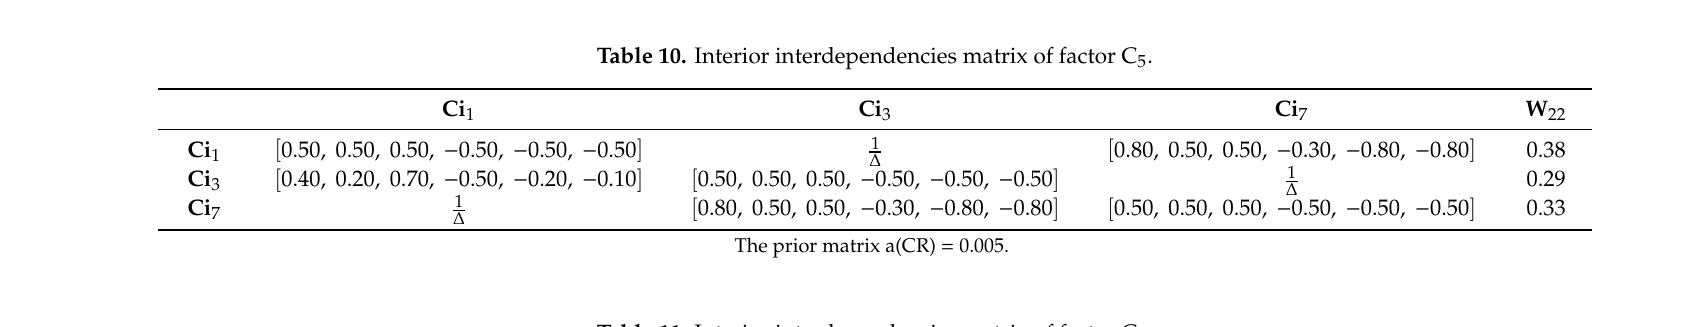
Table 11. Interior interdependencies matrix of factor C 6